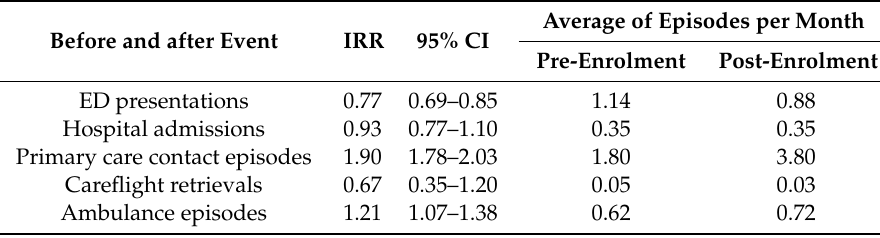
Table 4. Before-and-after impact of